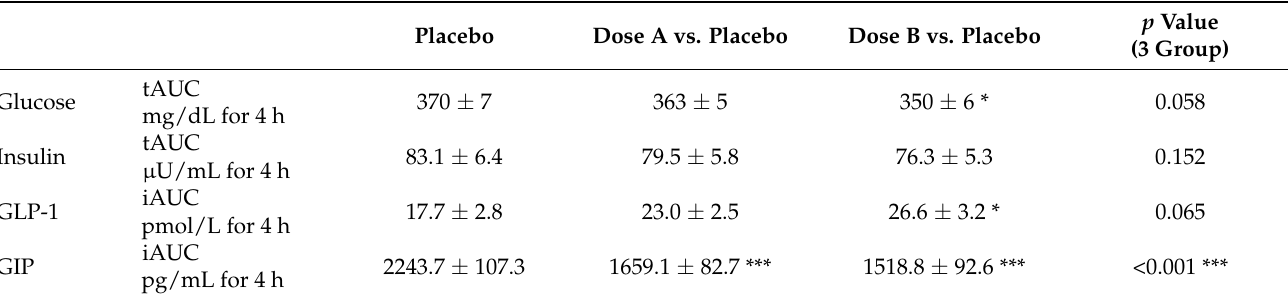
Table 3. AUC for blood-glucose-related indices and incretin up to 4 h after cookie meal ingestion in Study 1. Placebo Dose A vs. Placebo Dose B vs. Placebo